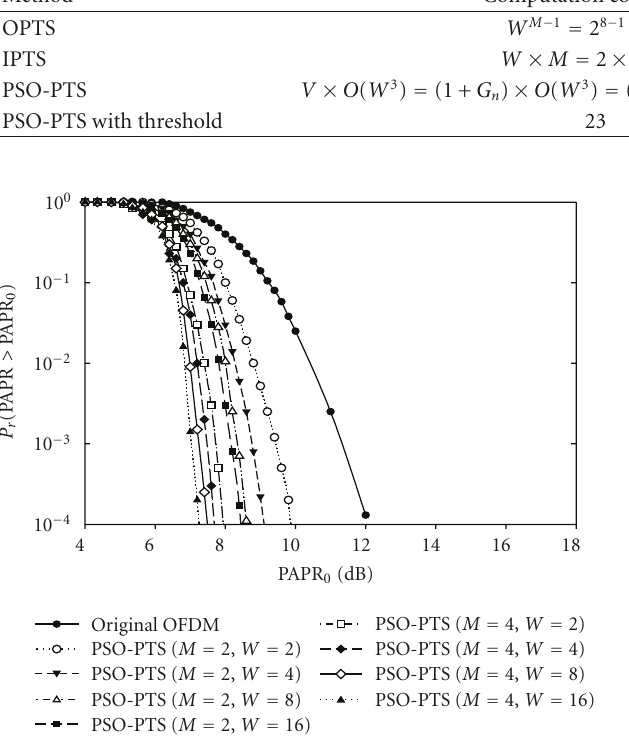
Figure 6: Comparisons of PSO-PTS technique under di ff erent phase weight factors and number of subblocks.